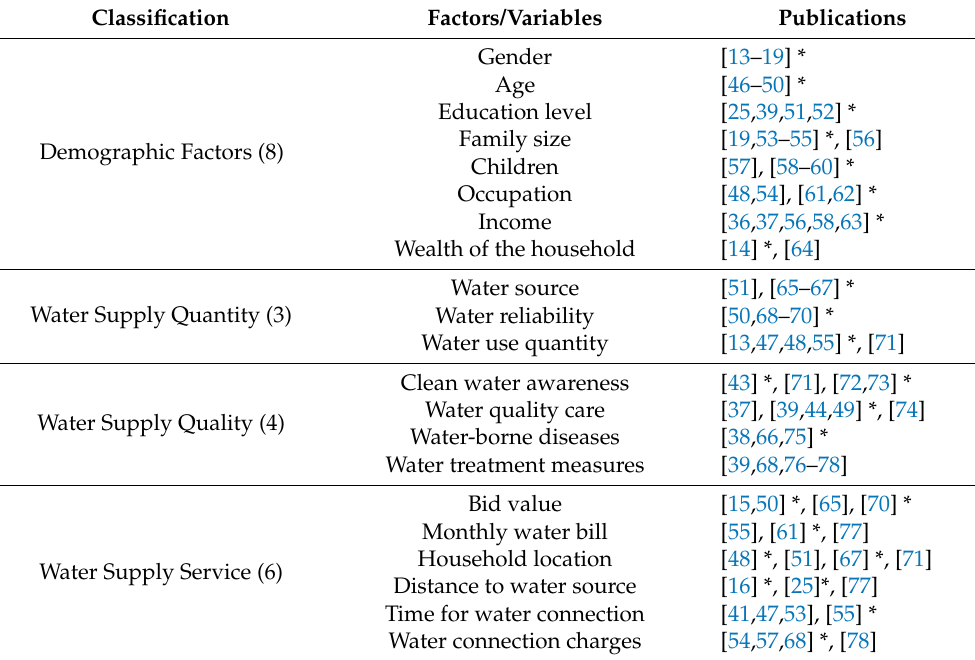
Table 1. Classification of 21 factors/variables considered to affect WTP according to the